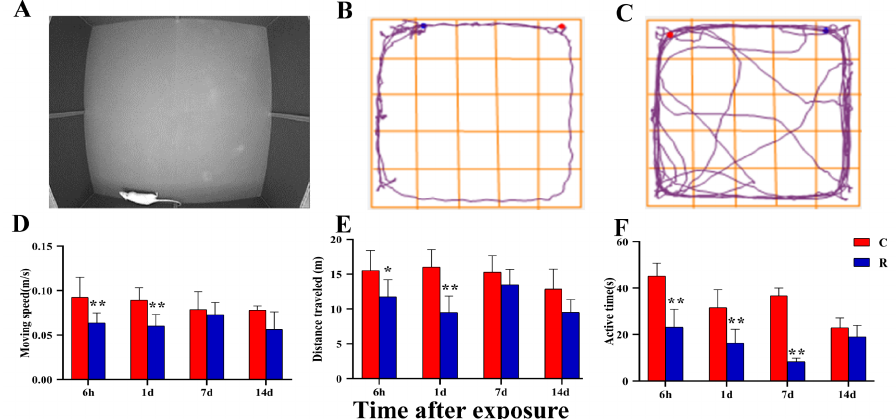
Figure 9. Changes noted during the open field experiment applied to rats after S-band radiation indicators of exercise ability. ( A ) The real shot of rats in the non-central area; ( B ) the trajectory diagram of Group R; ( C ) the trajectory diagram of Group C; ( D ) statistical analysis graph of moving speed; ( E ) statistical analysis graph of moving distance; ( F ) statistical analysis graph of active time. Significance signs were classified according to p -value: * p < 0.05 and ** p <